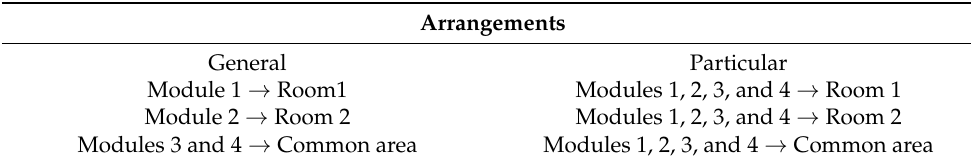
Table 3. Assignment of solar chimney modules by